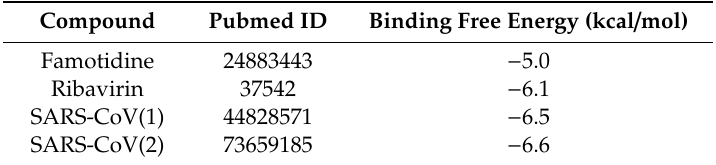
Table 3. Binding free energies calculated for famotidine and other protease inhibitors upon docking to the SARS-CoV2 papain-like